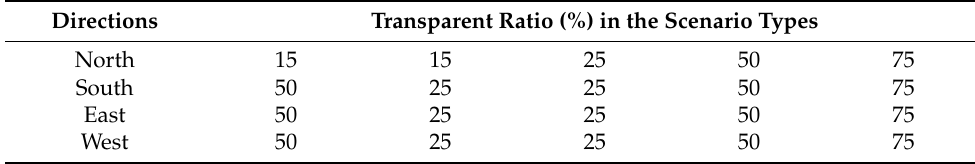
Table 4. Transparent ratios of building envelope according to directions in scenario types.